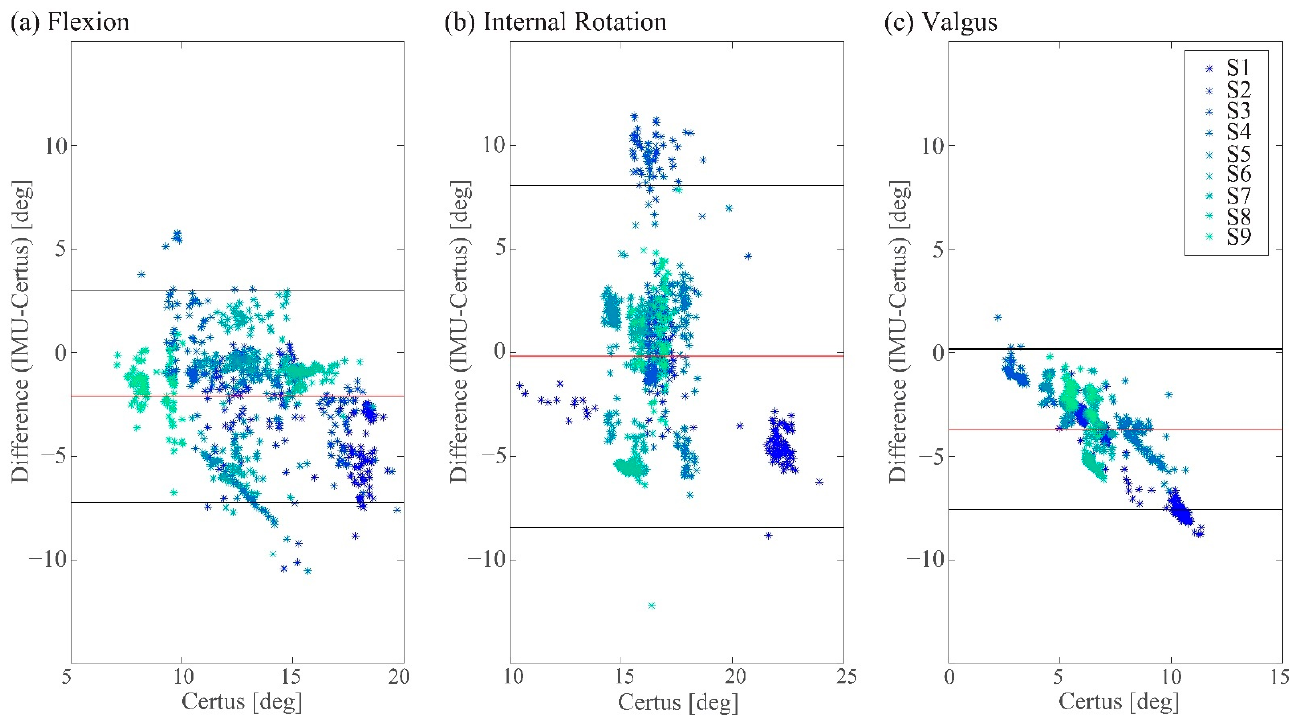
Figure 3. Bland–Altman plots comparing the measurements from the two IMUs with those of the motion capture system for measuring peak knee angle change in each direction during simulated jump landings. In this and the following figure, the different colors represent data from different knee specimens (S).